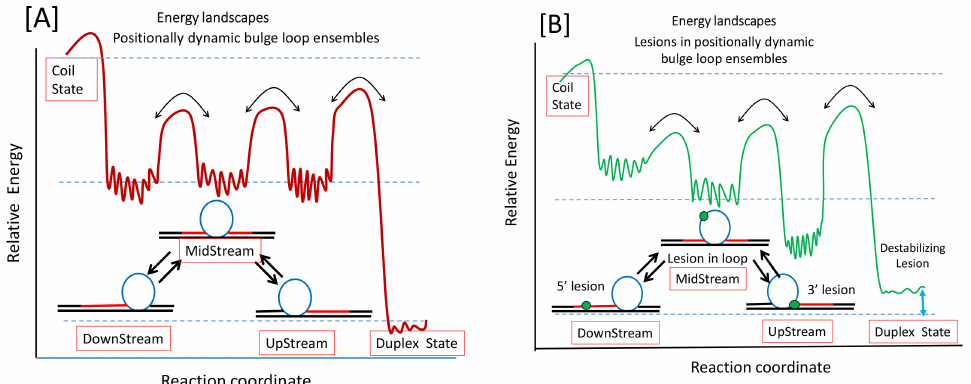
Figure 1. A schematic representation of the dynamic triplet repeat energy landscape in the absence ( A ) and presence ( B ) of a DNA lesion. The fine structure indicated by the squiggly lines within the wells of the rollamers reflects that each bulge loop positional isomer is itself comprised of ensembles of microstates, as we have previously demonstrated